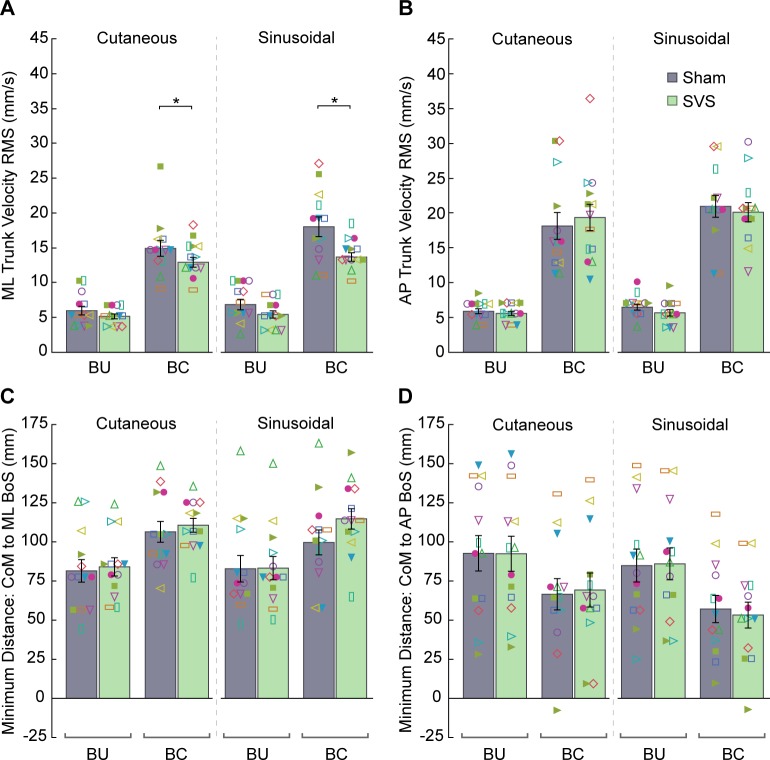
Results for the standing tasks.(A) Medial-lateral (ML) trunk velocity root mean square (RMS). (B) Anterior-posterior (AP) trunk velocity RMS. (C) The minimum distance between the center of mass (CoM), based on a chest position marker, and the ML base of support (BoS) during the standing task. (D) The minimum distance between the CoM and the AP BoS during the standing task. Data are mean ± SE. Individual participant data are superimposed. Asterisks indicate differences between sham and stochastic vestibular stimulation (SVS) conditions based on post-hoc tests following a significant balance condition x stimulation condition interaction (p < 0.05). Details of the other significant effects are reported in Table 2.